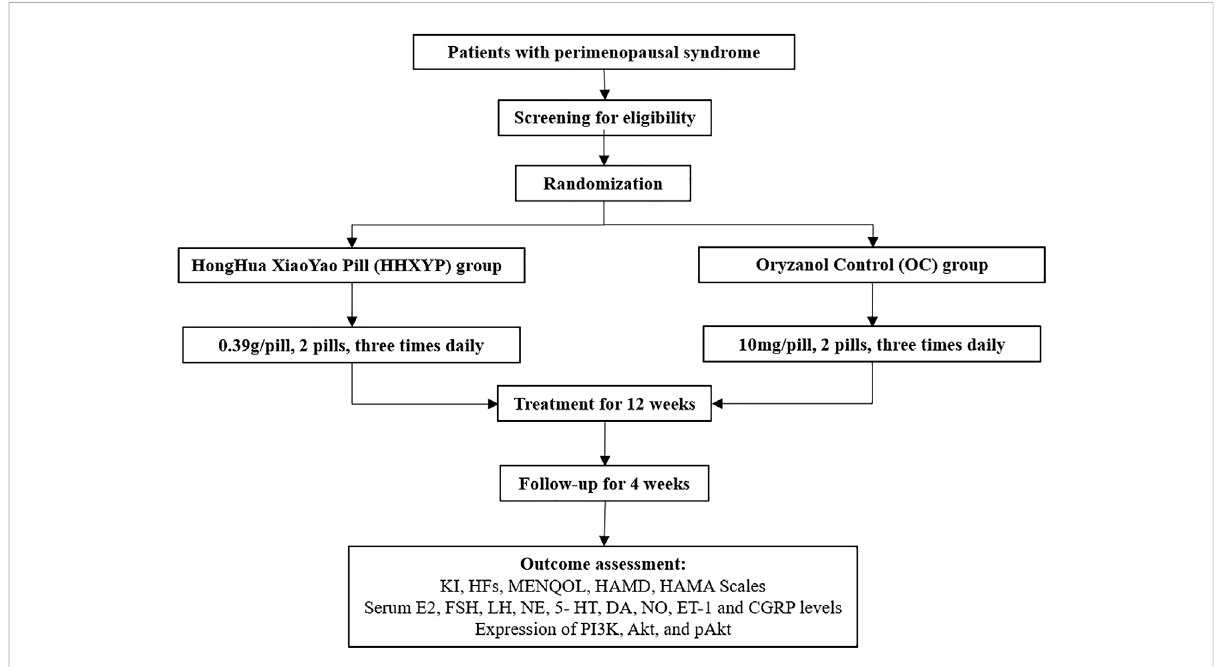
FIGURE 1 Flow diagram of the